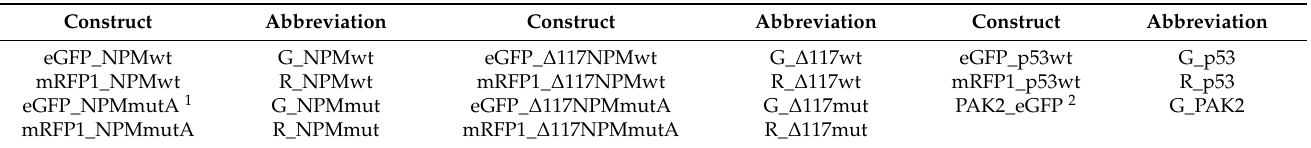
Table 1. List of constructs. All protein constructs except PAK2_eGFP are tagged on their N-terminus. Symbol “/” denotes mixture of constructs in text of the